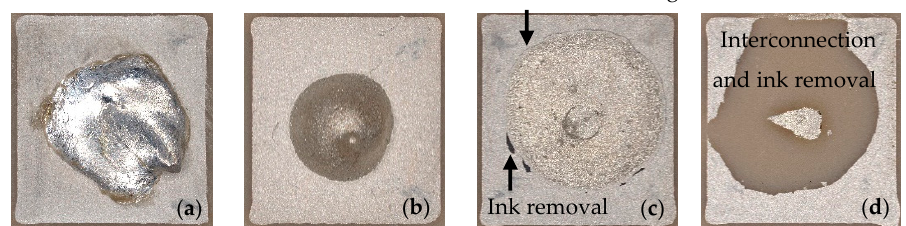
Perimeter cracking